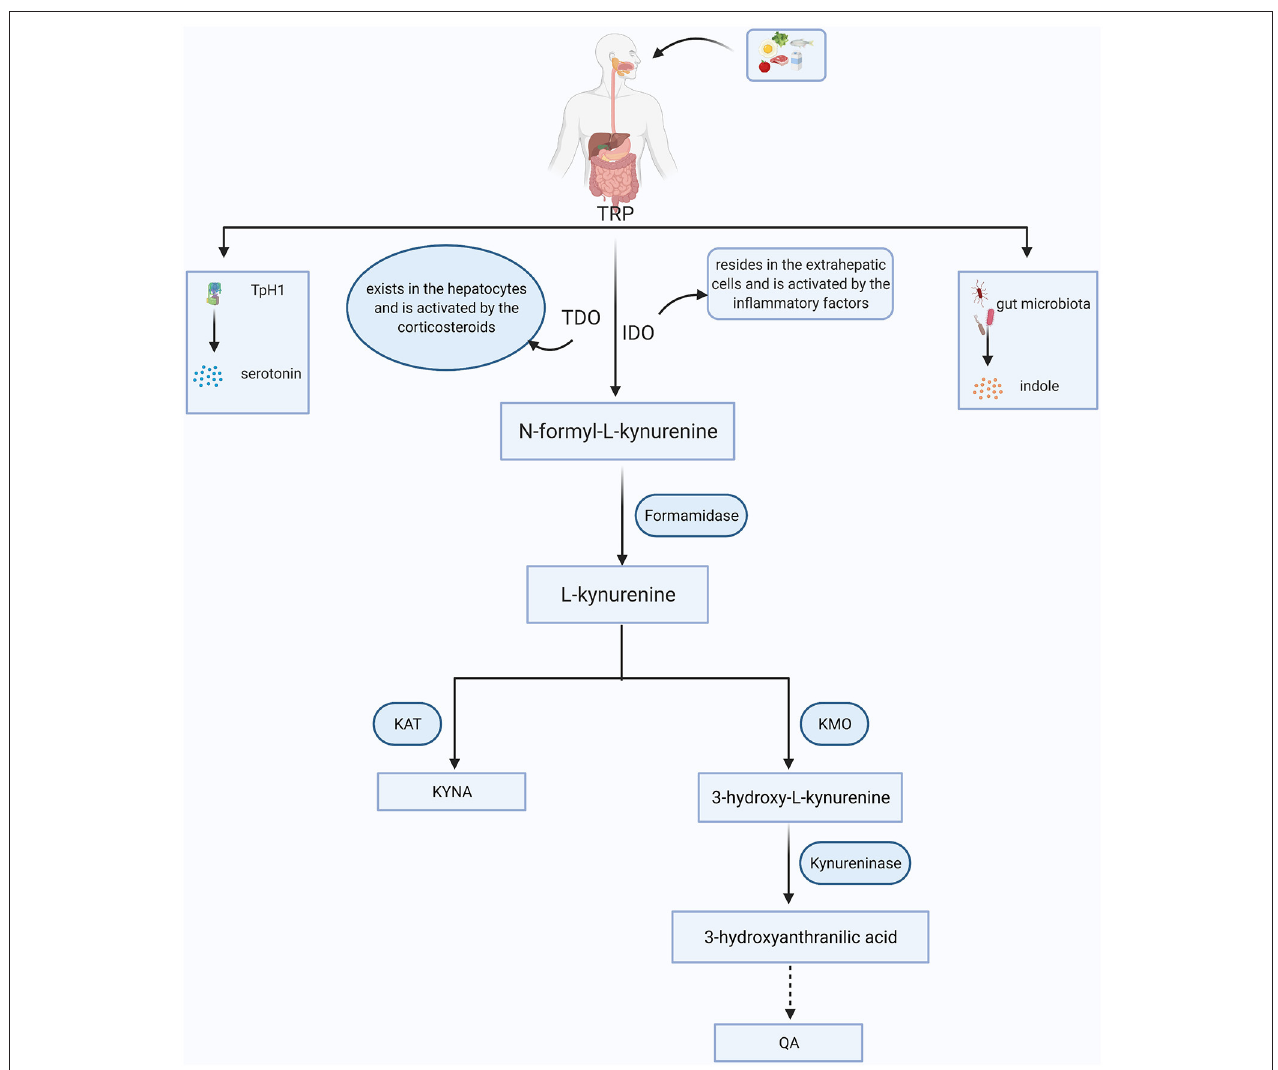
FIGURE 1 | The simplified KYN metabolism pathways in general. Tryptophan (TRP) is obtained from food. Besides being converted into serotonin through tryptophan hydroxylase 1 (TpH1) and indoles via gut microorganism, more than 90% of TRP is broken down to the N-formyl-L-kynurenine with the aid of tryptophan 2,3-dioxygenase (TDO) or indoleamine 2,3-dioxygenase (IDO). N-formyl-L-kynurenine is further degraded to kynurenine (KYN) via formamidase and the KYN can be converted into kynurenic acid (KYNA) and quinolinic acid (QA) mainly depending on the kynurenine aminotransferase (KAT) and kynurenine 3-monooxygenase (KMO),